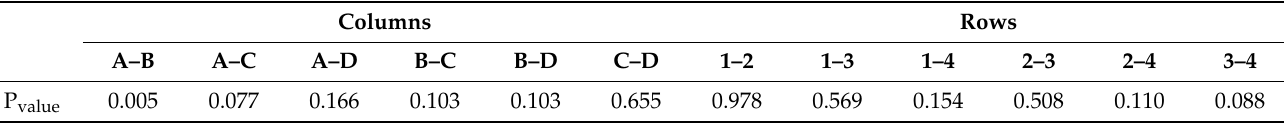
Table 7. Analysis of significant differences between positions according to the t -test. Columns